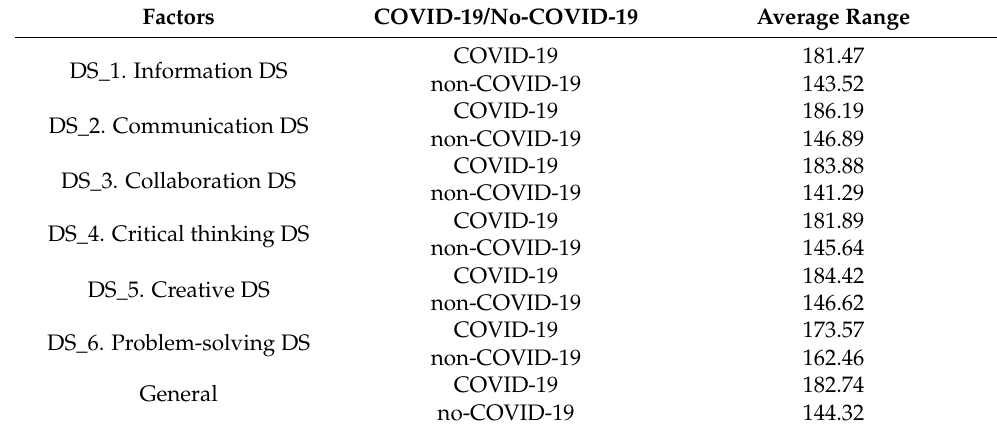
Table 7. Pre-test average ranges by DS